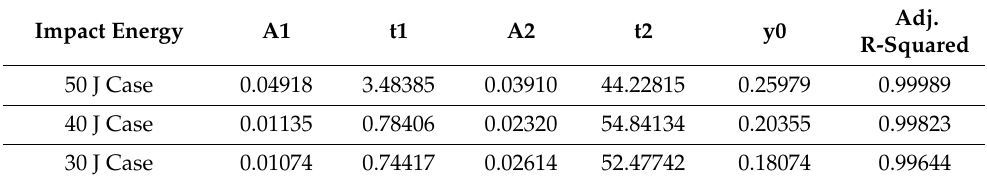
Table 6. Variable values of fitting curve equation for 30 J, 40 J, and 50 J impact cases.